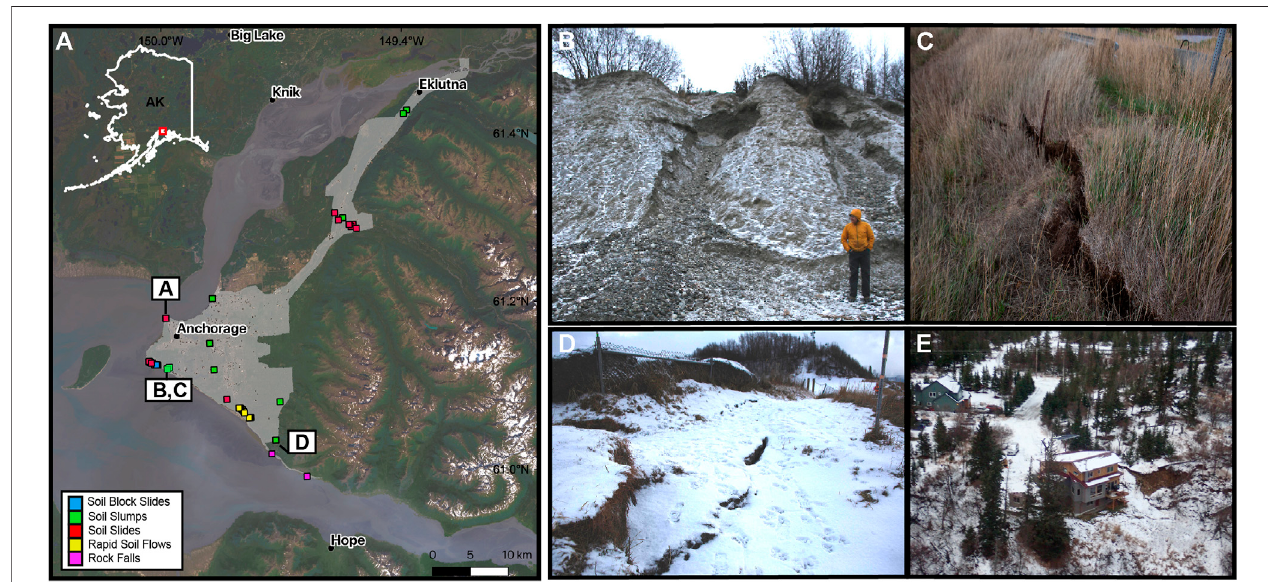
FIGURE 2 | The map on the left (A) shows the location of landslides by type as well as the location of those landslides that could not be delineated using remote sensing mapping methods (labeled B – E on the map). Corresponding photos of those landslides can be seen to the right of the map. The top center photo shows a (B) soil slide with a person for scale. The top right (C) and bottom center (D) show incipient soil slumps and the bottom right (E) shows a soil slide. (Photo Credits: USGS).